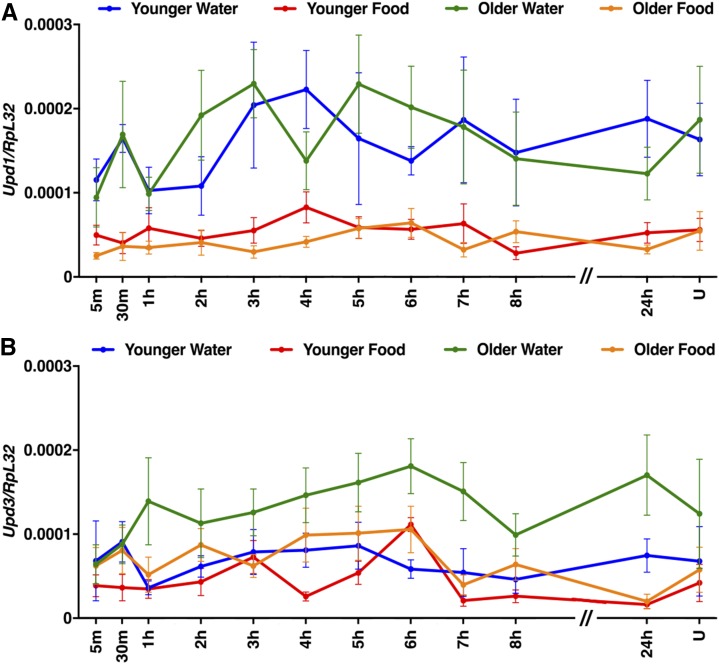
Age and diet did not affect expression of Upd family genes following primary injuries. (A and B) Expression of the indicated genes relative to RpL32 following the standard injury protocol in w1118 flies under the indicated conditions. Note that the x-axis is not to scale between 8 and 24 hr. U indicates uninjured flies at the 24 hr time point. Each data point is the average and SEM of at least three biological replicates.